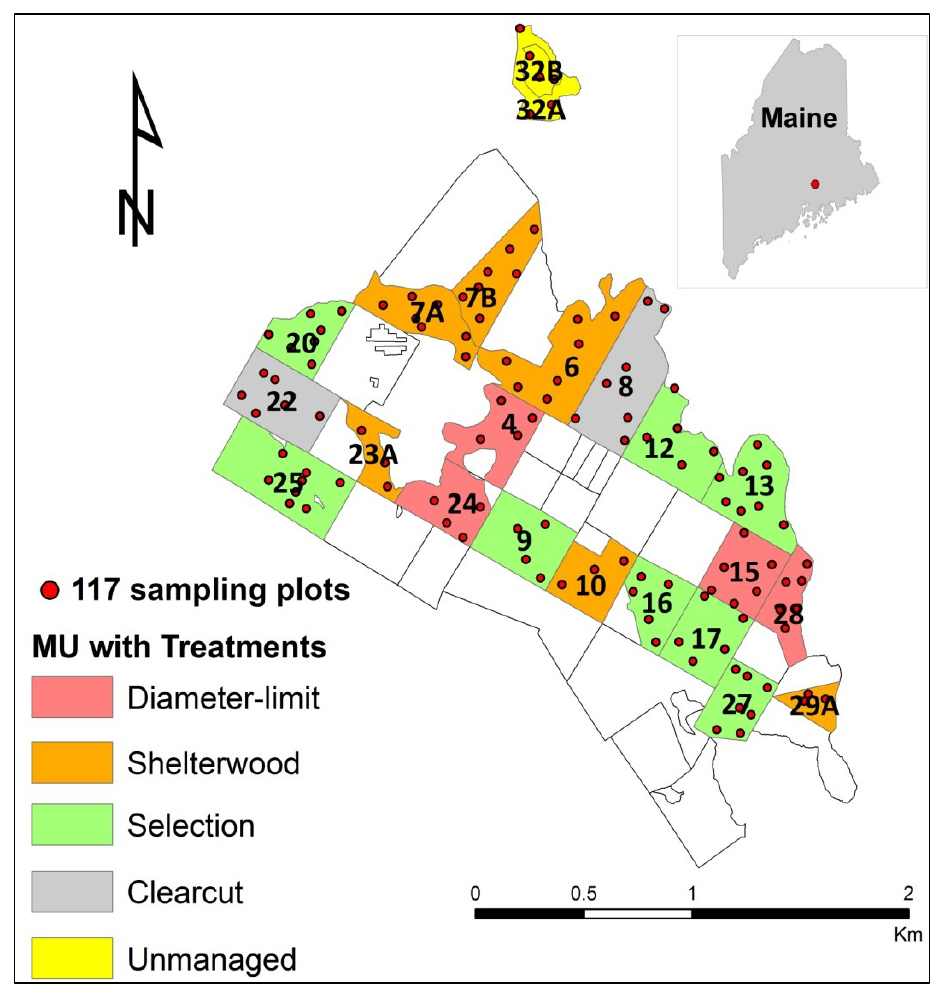
Figure 1. The Penobscot Experimental Forest near Orono, Maine, USA (N44°49’30‖, W68°39’00‖). Eleven different silvicultural treatments (a total of 22 management units) have been monitored with long-term permanent sampling plots. MU, management